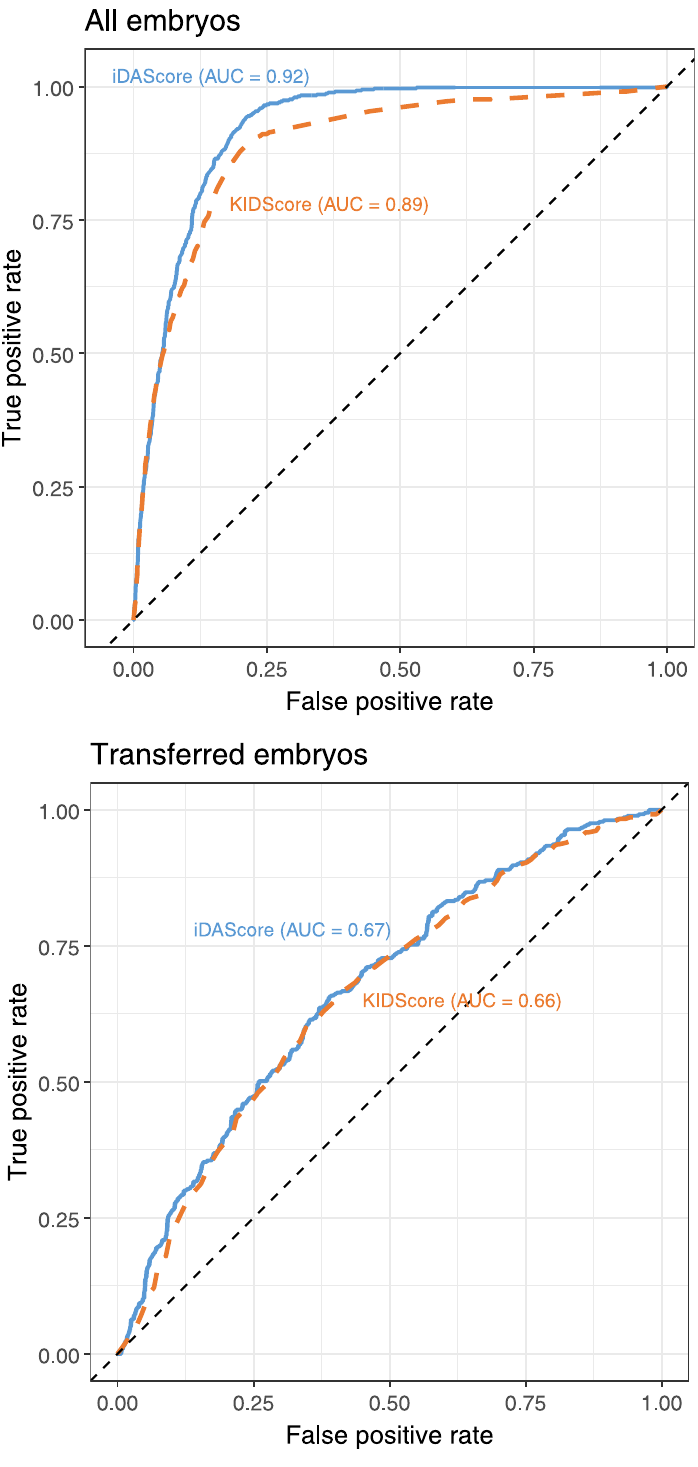
Fig 3. Comparison between ROC curves based on iDAScore (solid blue) and KIDScore (dotted orange). The upper plot shows the ROC curve for the whole embryo cohort (n = 7,932), and the lower plot shows the ROC curve for KID embryos (n =